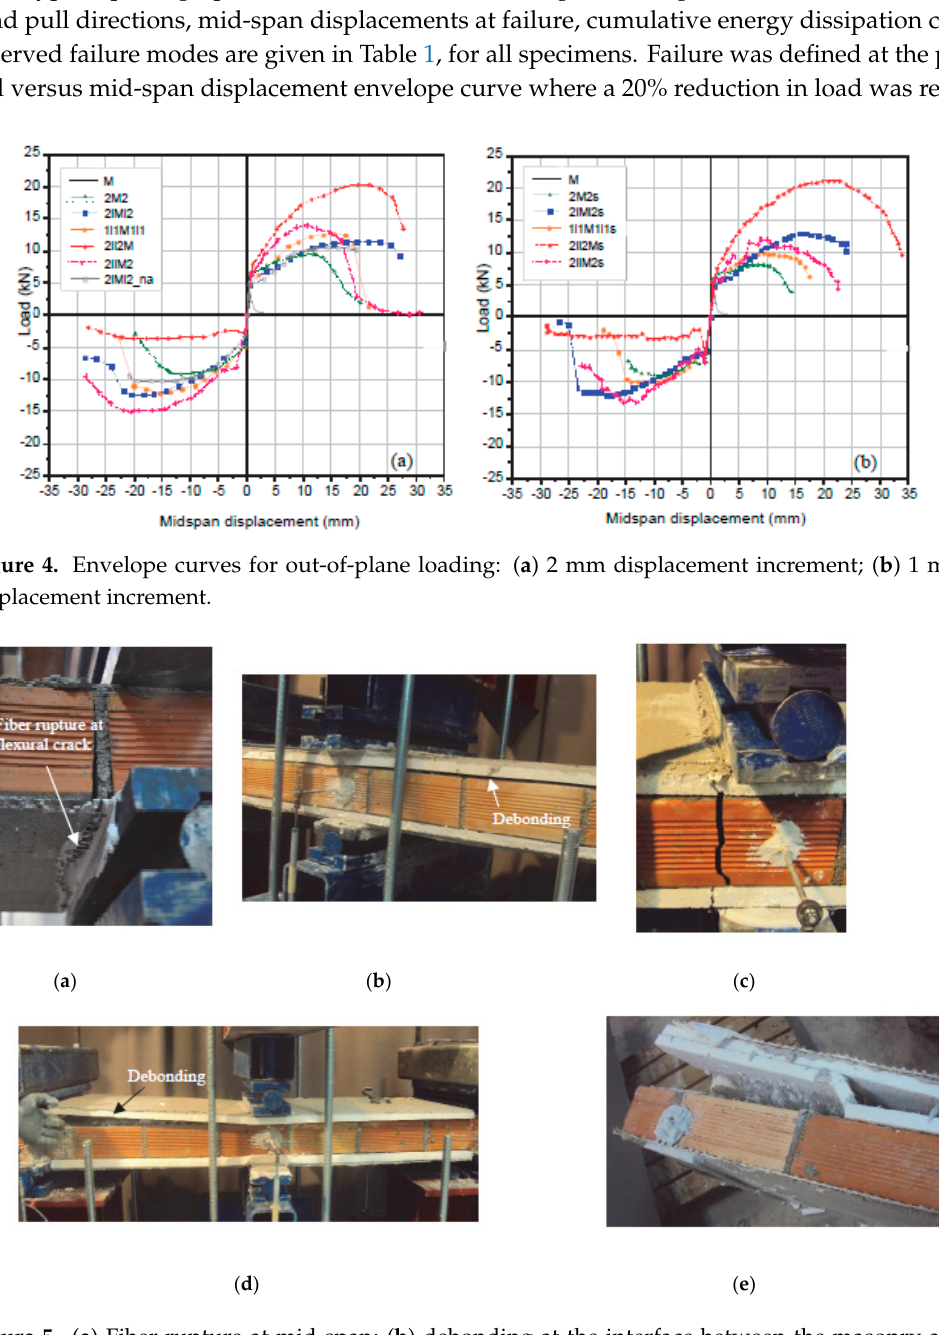
Figure 5. ( a ) Fiber rupture at mid-span; ( b ) debonding at the interface between the masonry and the insulation; ( c ) flexural cracking through the insulating material; ( d ) debonding, as a result of unfavorable anchorage conditions; and ( e ) debonding at the insulation–masonry interface propagates through the two insulation layers.